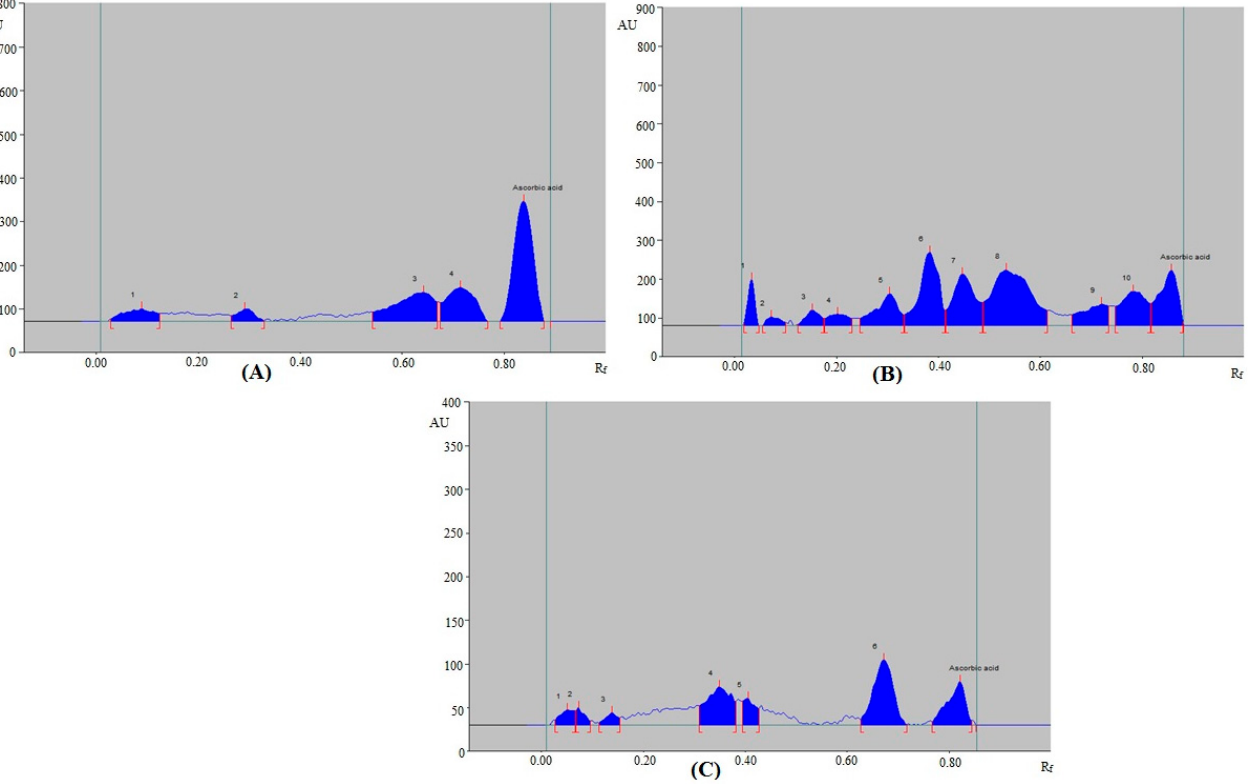
Figure 4. Representative HPTLC densitograms of AA in the UAE of ( A ) P. emblica , ( B ) P. guajava , and ( C ) C. annuum . Table 6. Application of the greener HPTLC method for the estimation of AA in the SE and UAE of P. emblica , P. guajava , and C. annuum a